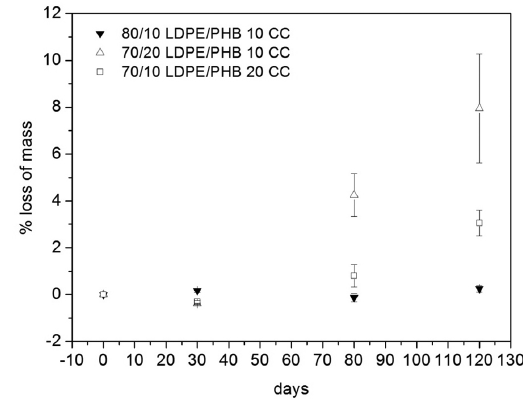
Figure 5. Percentage of loss of mass of LDPE/PHB/CC mixtures in different intervals of time.